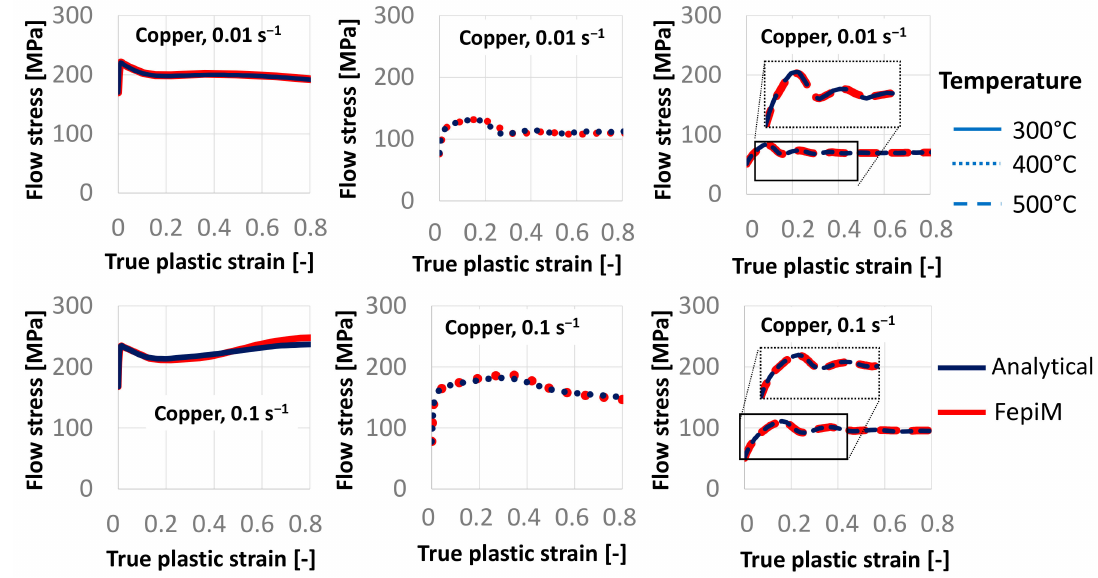
Figure 8. Flow curves for copper at different temperatures and strain